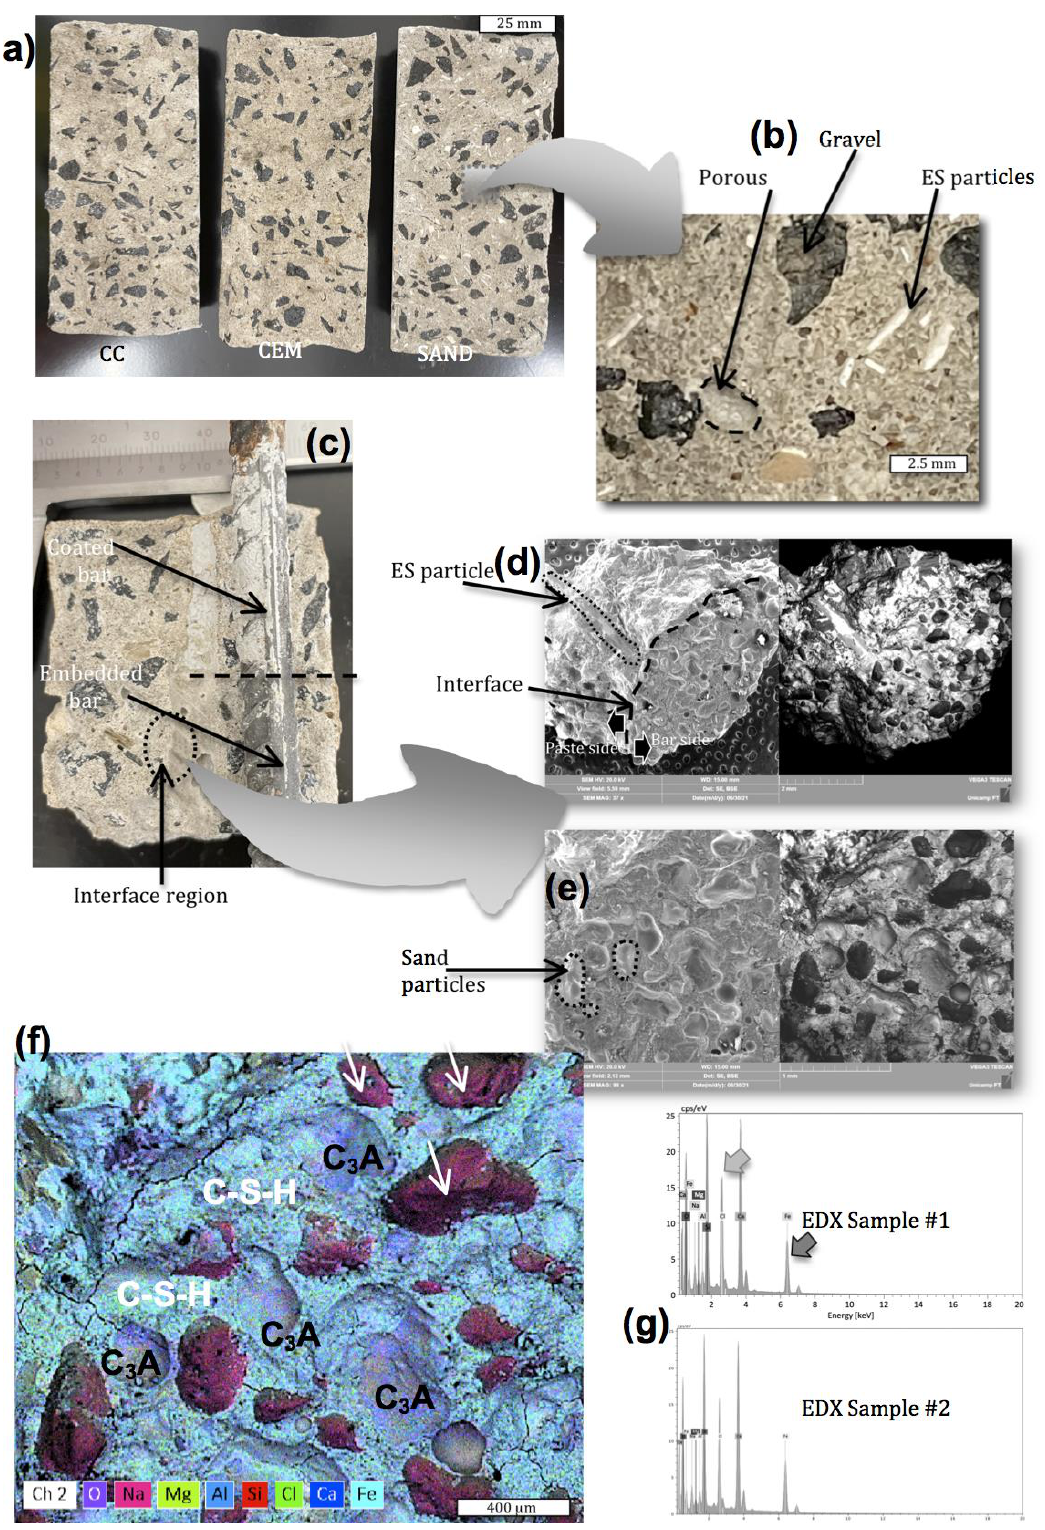
Figure 13. ( a ) The CC, CEM and SAND sample depicting the concrete microstructure, ( b ) showing elements constituting concrete including ES (egg-shell) particles, ( c ) demonstrating the local at interface bar/concrete where the samples were withdrawn, ( d , e ) SEM images obtained at interface bar/concrete, and ( f , g ) elemental map and EDX diagrams of the SAND sample.